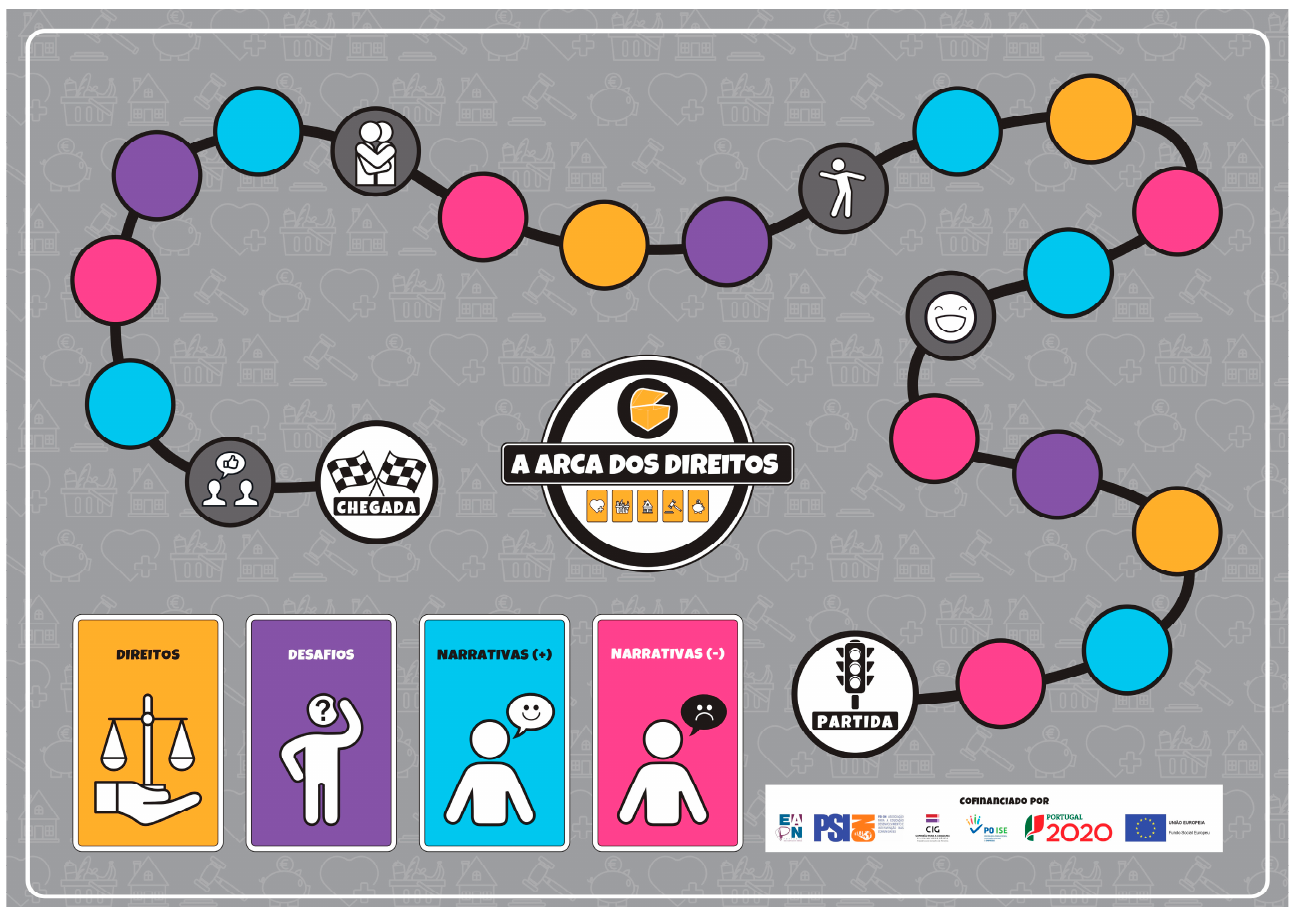
Figure 1. “The Ark of Rights” board game.